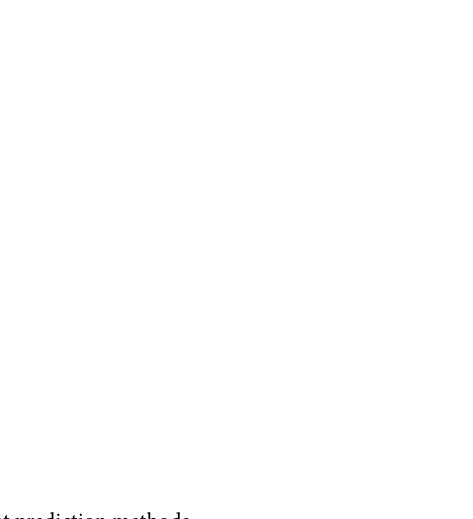
Figure 10. Comparison of calculation time of different prediction methods.